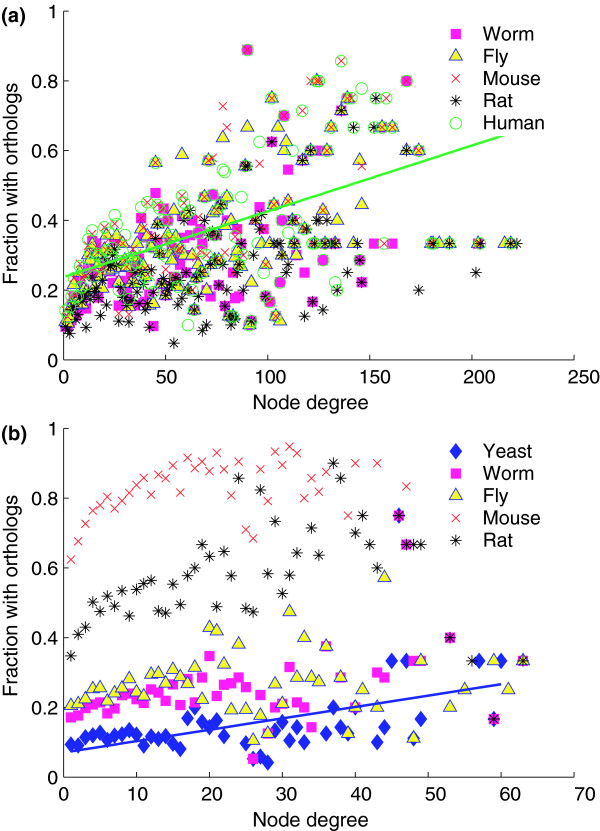
Conservation of interacting proteins by degree. (a) Each protein in the yeast interaction network was examined for orthologous proteins in the five higher eukaryotes, and binned according to degree. The proportion of each bin with orthologous proteins is shown. The linear trend shows the strong positive correlation (Spearman's rank r = 0.52, P = 2.8 × 10-11) between yeast and human proteins. (b) The proteins in the human interactome were compared against all five lower eukaryotes, and binned according to degree. This trendline also shows a strong correlation against yeast (Spearman's rank r = 0.50, P = 3.9 × 10-4), which is similar for worm and rat, and there is a weak (non-significant) correlation to fly. There was a weak negative correlation in mouse (Spearman's rank r = -0.02); however, the overall conservation was high, likely biasing this measurement.